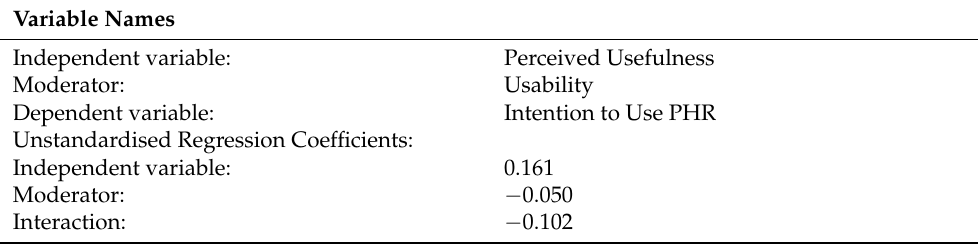
Figure 4. Usability Lessens the Positive Relationship between Perceived Usefulness and Intention to Use PHR. Table 8. Two-way Interaction Effects for Unstandardised Variables (PU, Usability, and Intention to Use PHR).